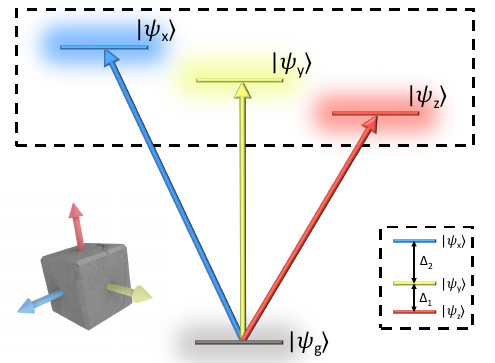
Figure 1. Fine-structure of orthorhombic phase perovskite nanocrystals. Transitions from the exci- (cid:12) (cid:11) tonic ground state to the bright triplet states | ψ i (cid:105) , where i = { x , y , z } , are polarized along the (cid:12) ψ g orthorhombic symmetry axes. We note that the case of a fully nondegenerate triplet manifold shown here assumes an orthorhombic phase perovskite lattice